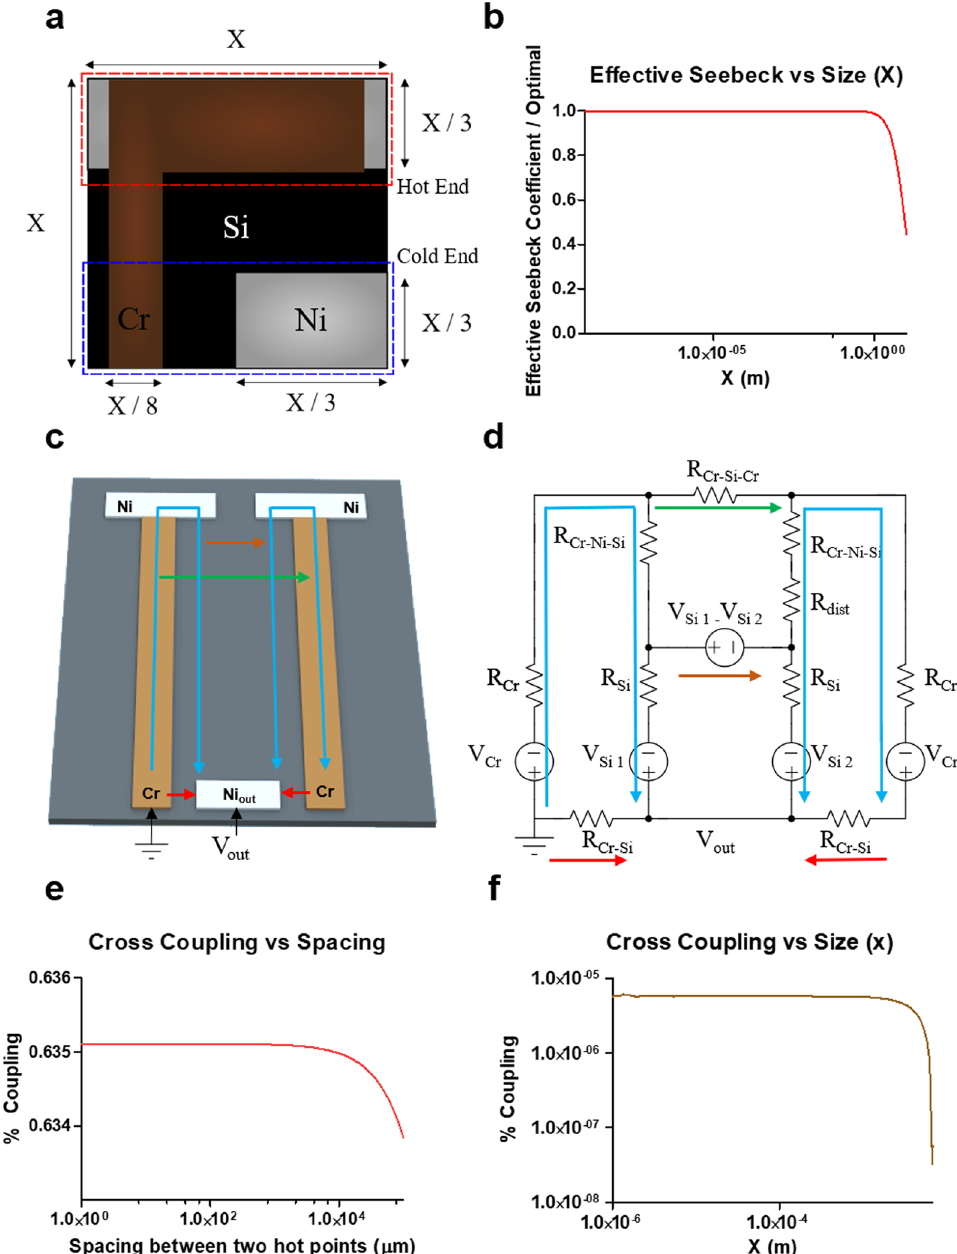
Figure 2. ( a ) Diagram of a thermocouple unit cell which measures the temperature between its hot point (top of the diagram) and the cold end (bottom of the cell). The Cr metal arm is in brown, the Ni ohmic contact in silver, and the silicon substrate in black. In our simulation and analysis, we assume the unit cell has a size of X by X. ( b ) The effective Seebeck coefficient versus the characteristic size (x): the Seebeck coefficient goes down only when the size increases approximately above one meter and remains high and constant for micro scale measurements. ( c ) Schematic of two thermocouples adjacent to each other on a shared silicon substrate with individual current paths. The blue path corresponds to the ideal current path leading to no cross coupling and voltage loss. The red path corresponds to the lossy path through which no thermal voltage is produced. The green arrow indicates one possible cross coupling path where current goes from one Cr strip to the other Cr strip through two Schottky barriers. The brown arrow shows the other cross coupling path where current goes from one Ni hot point to the other through the Si substrate. ( d ) Equivalent circuit model for the two devices shown in ( c ). R dist is an additional resistance that exists between the two points. ( e ) Cross-coupling (%) between the two hot points as a function of physical separation: the measurements represent the percent increase in temperature measured at one cold end caused by the increase of temperature at the hot point of the other device due to electrical crosstalk between them. The magnitude of the coupling remains small and relatively constant ( < 0.7%) below 1-mm separation. ( f ) Cross- coupling versus the unit size: the cross coupling remains relatively constant and negligible around 1 × 10 − 5 % as the device size is decreased, suggesting that the cross coupling does not limit the device